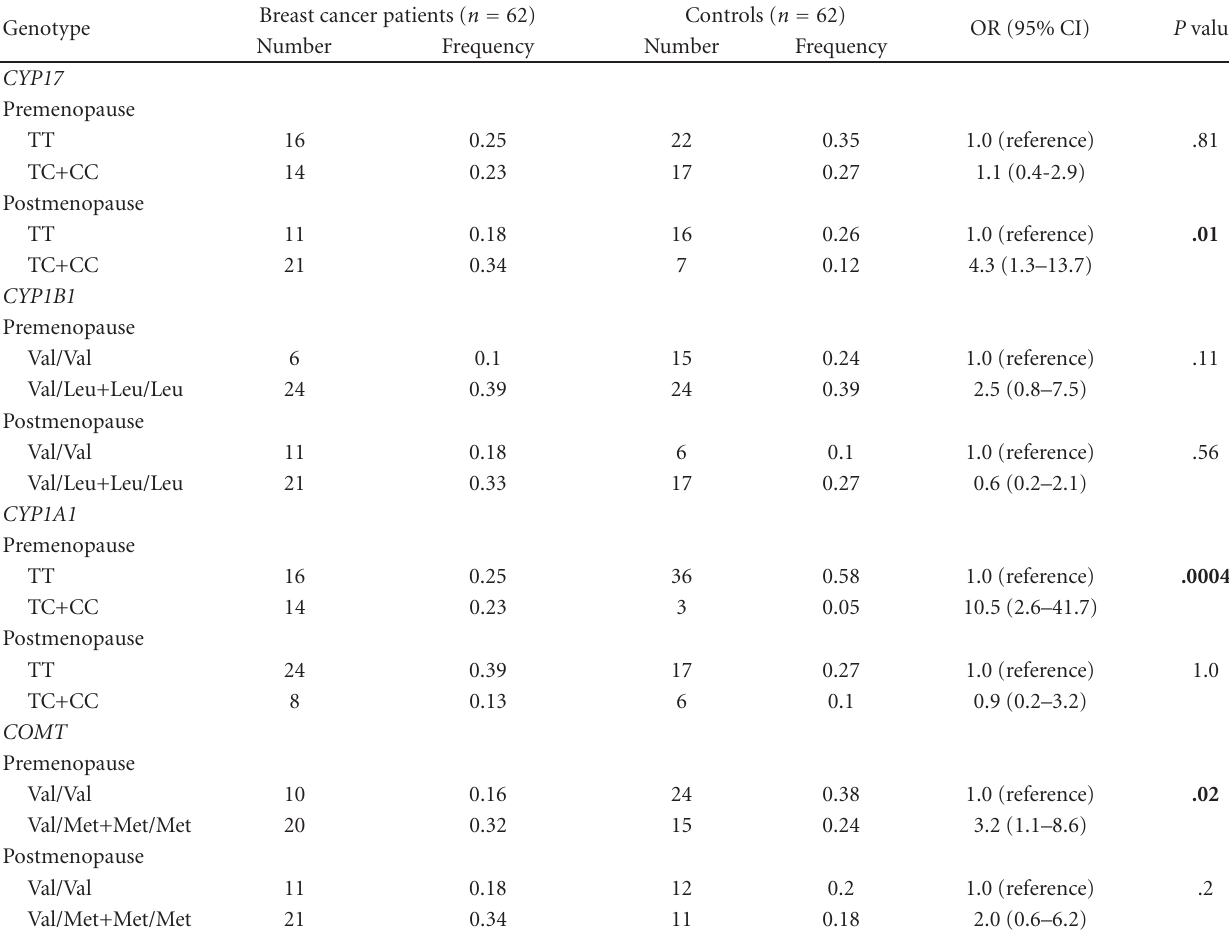
Table 2: The genotype frequencies of the CYP17 , CYP1B1 , CYP1A1 , and COMT gene variants in breast cancer patients and controls, and after menopause.